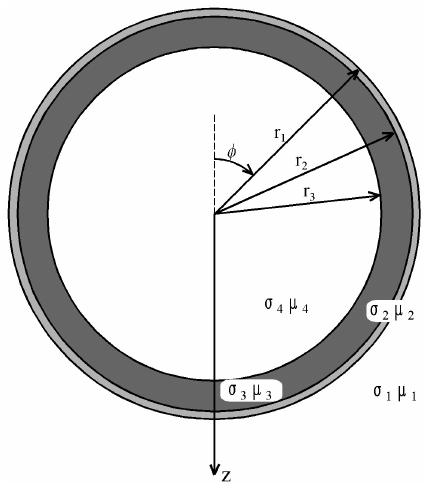
Fig. 4. Coordinate system and characteristics of the pipeline layers.